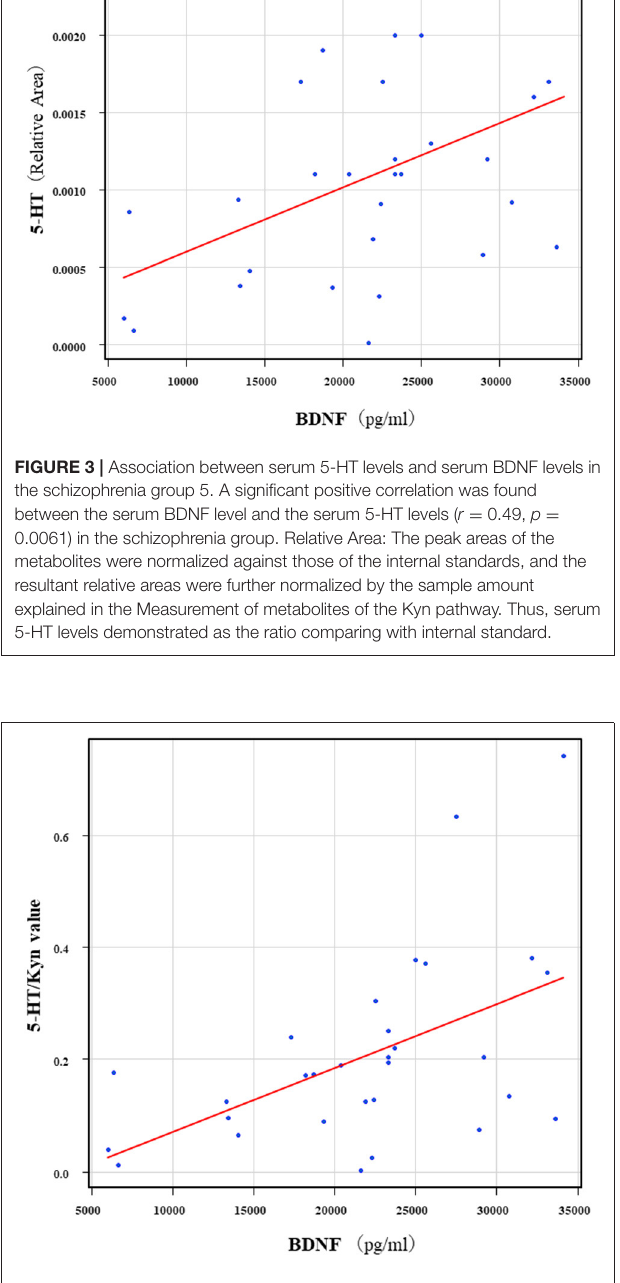
FIGURE 4 | Association between the serum BDNF levels and the 5-HT/Kyn value in the schizophrenia group. A significant positive correlation was found between the serum BDNF levels and the and the 5-HT/Trp value ( r = 0.55, p = 0.0018) in the schizophrenia group.